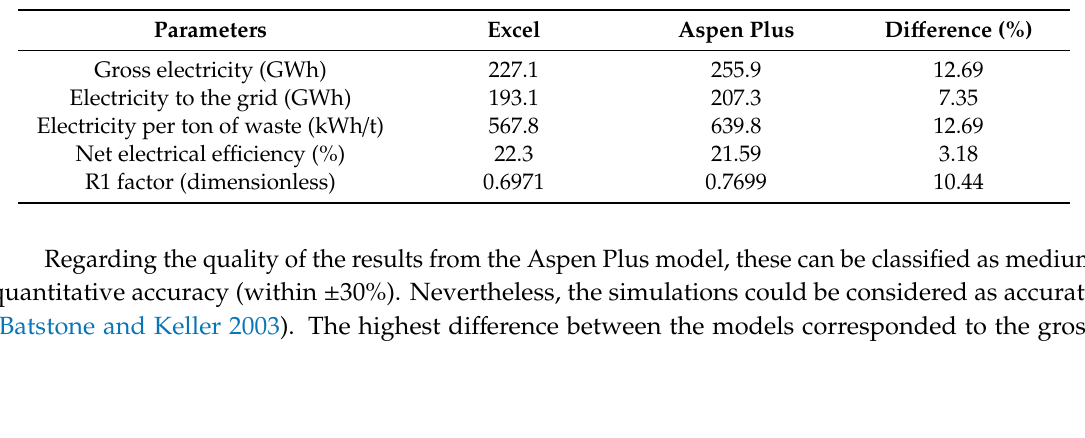
Table 3. Thermodynamic parameters from Excel and Aspen Plus models.